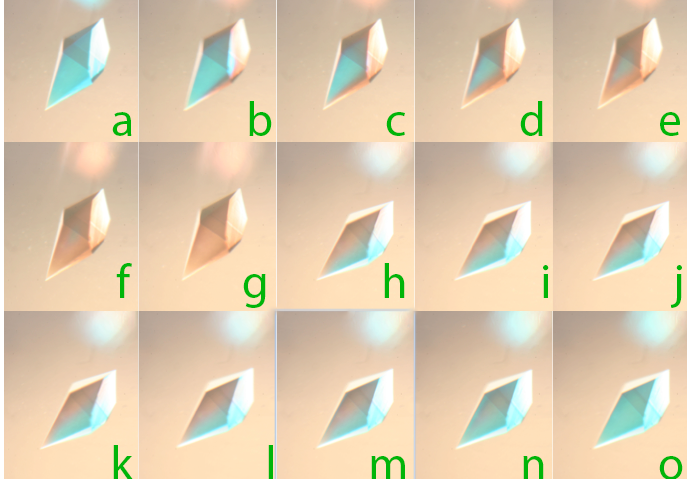
Figure 9. A tetragonal crystal of thaumatin about 1 mm in length was saturated with the redox sensitive dye Luxol blue (Solvent blue 38) giving it an intense blue color. Luxol blue is a porphyrin that contains a copper ion in the plus two state that is responsible for the color. Solid dithionite was added directly to the mother liquor, which reduced the Cu 2+ ion to elemental copper. Thus, the transformation of color in the crystal from blue to copper shows the progress of the reduction reaction as the dithionite penetrated the crystal. Beginning with image ( h ), oxygen in the environment initiated re-oxidation of the copper and the color transitioned again to blue. This is shown in the final images ( i ) through ( o ). The series of images ( a – o ), taken at appropriate time intervals, shows the progress of the dye.